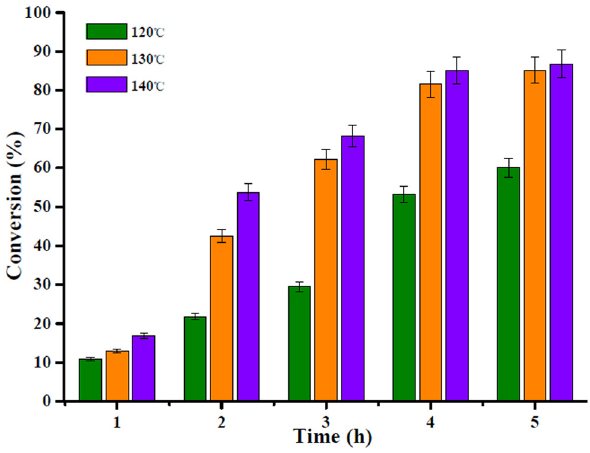
Figure 7: Evaluation of e ff ects of reaction temperature and time on catalyst for the conversion of oleic